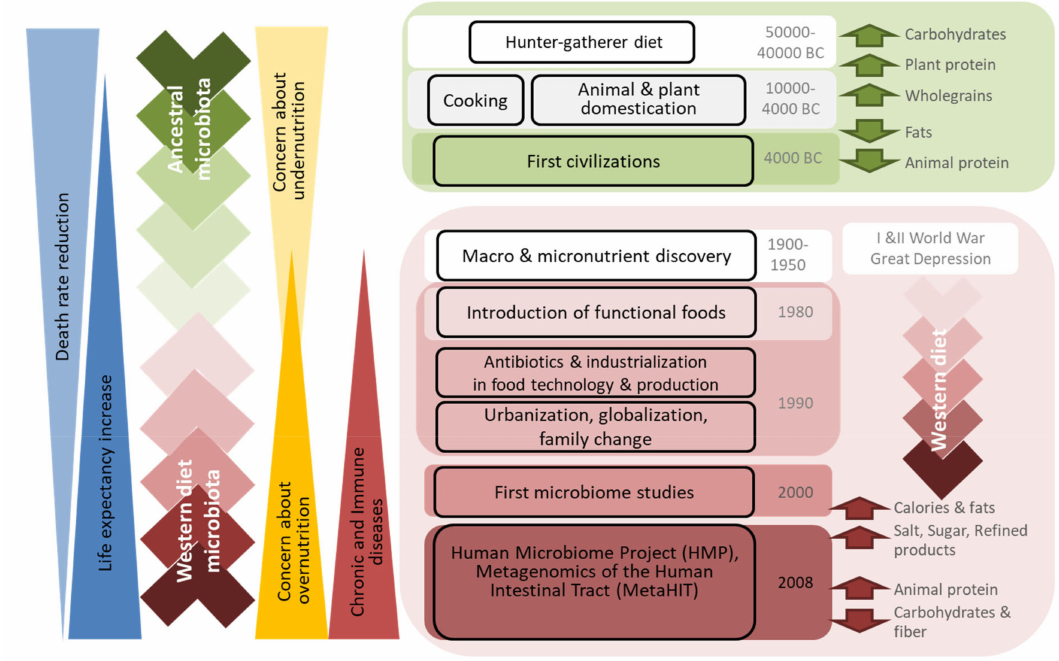
Figure 2. Drivers of dietary trends and their relation to microbiota composition and changes in human